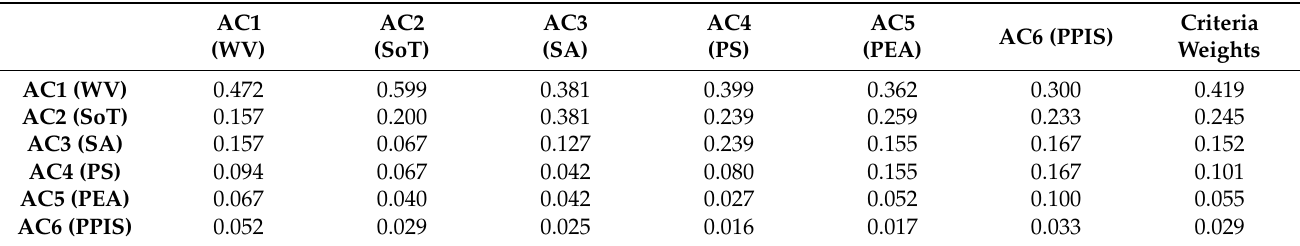
Table 5. Normalized pairwise comparison matrix of the assessment criteria with respect to the goal under Scenario 1.